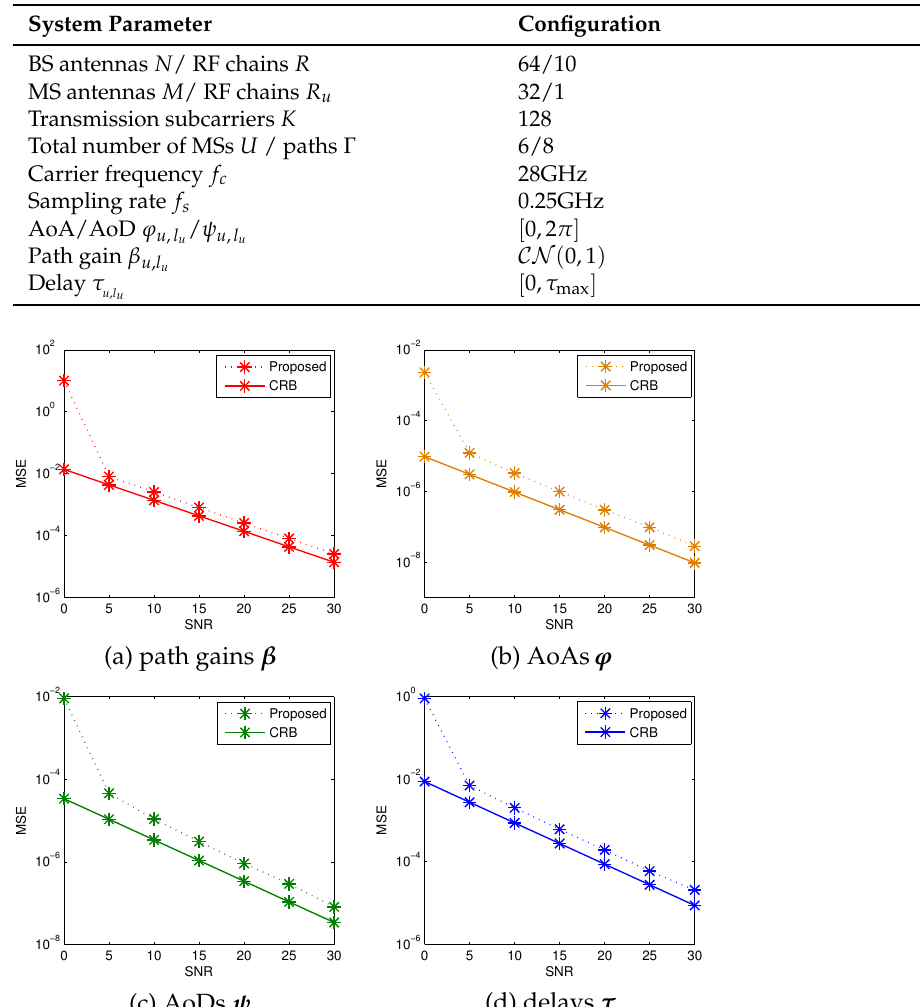
Figure 2. MSEs and CRBs of channel parameters versus